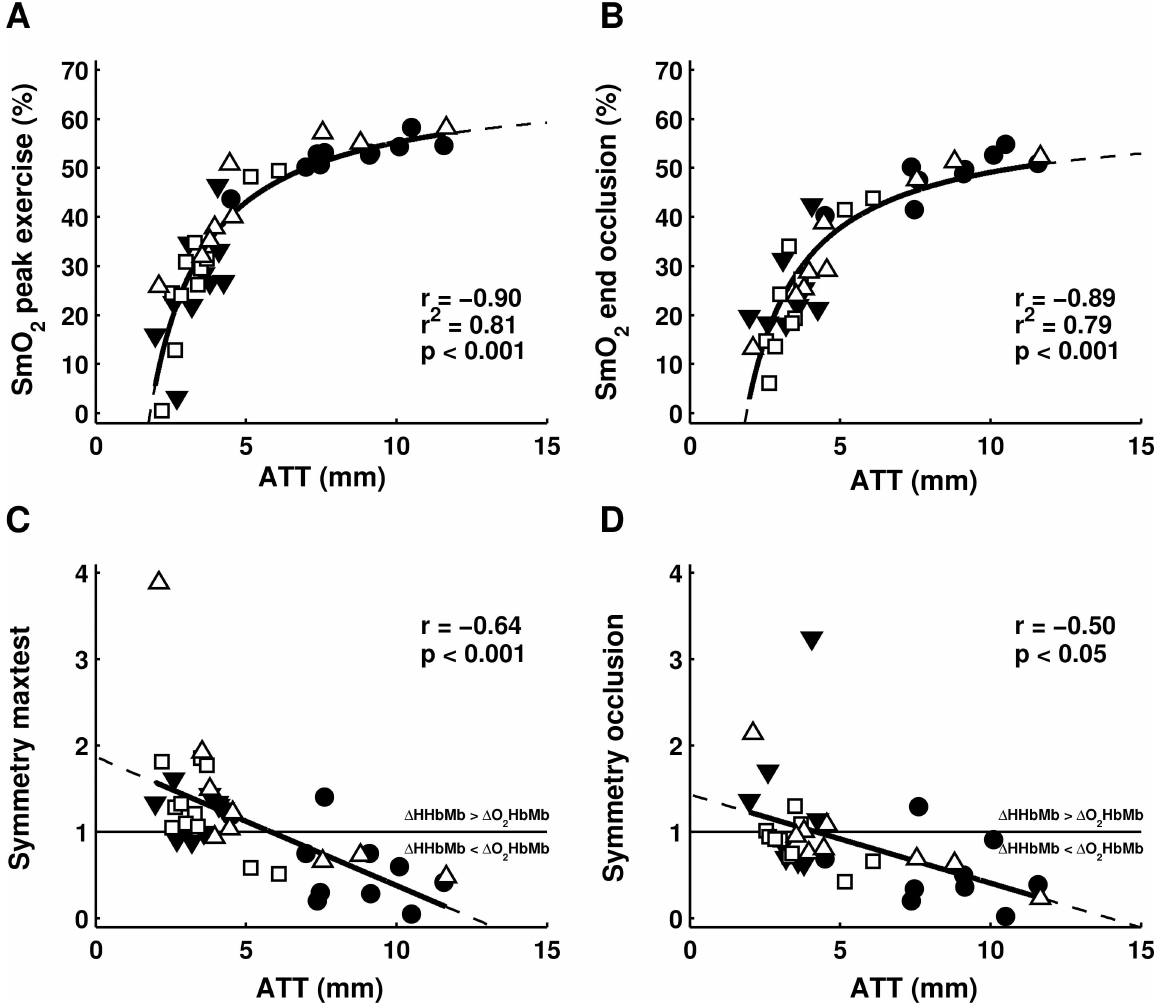
Fig 3. ATT affectsSmO 2 and symmetryof deoxygenated and oxygenatedhaemoglobin and myoglobin. Adipose tissue thickness is hyperbolically relatedto SmO 2 at peak exercise (a) and at the end of arterialocclusion(b).Symmetryof